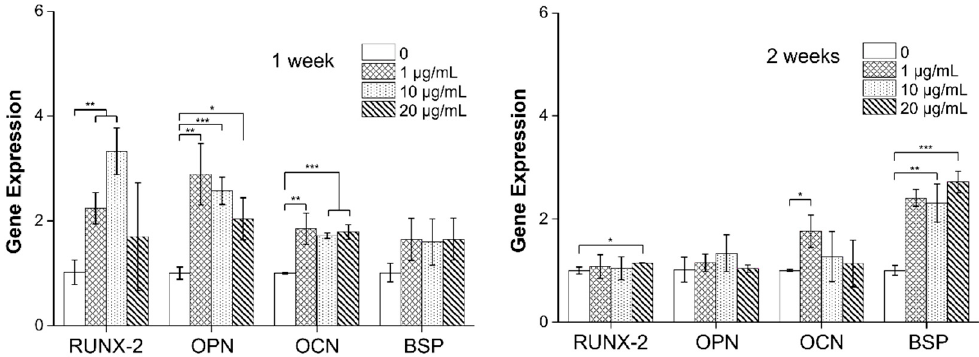
Figure 6. qRT-PCR after in vitro hMSCs culture to investigate the concentration of tissue culture plate and MXene treatment after 7 days and 14 days incubation. Early maker RUNX2 and OPN, middle maker OCN, late maker BSP (* p < 0.05, ** p < 0.01 and *** p < 0.001).